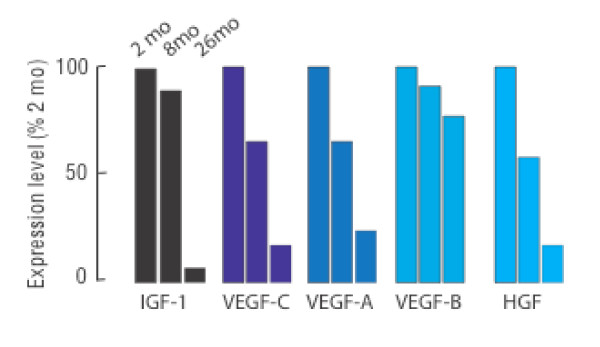
Microarray profiles of pro-angiogenic cytokines and growth factor genes.  Expression levels of IGF-1, VEGF-A, VEGF-B, VEGF-C and HGF were from microarray.